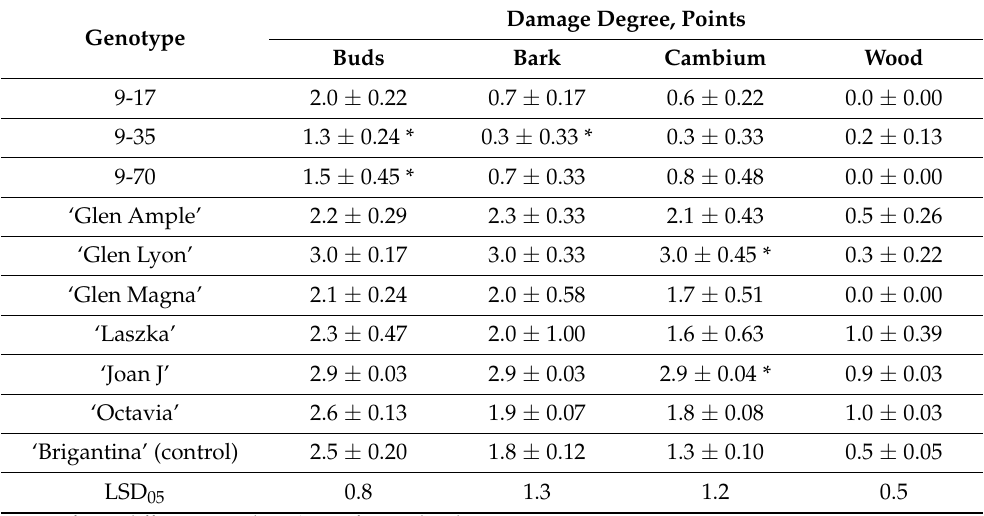
Table 4. Raspberry damage at − 35 ◦ C (the second winter hardiness component), average for